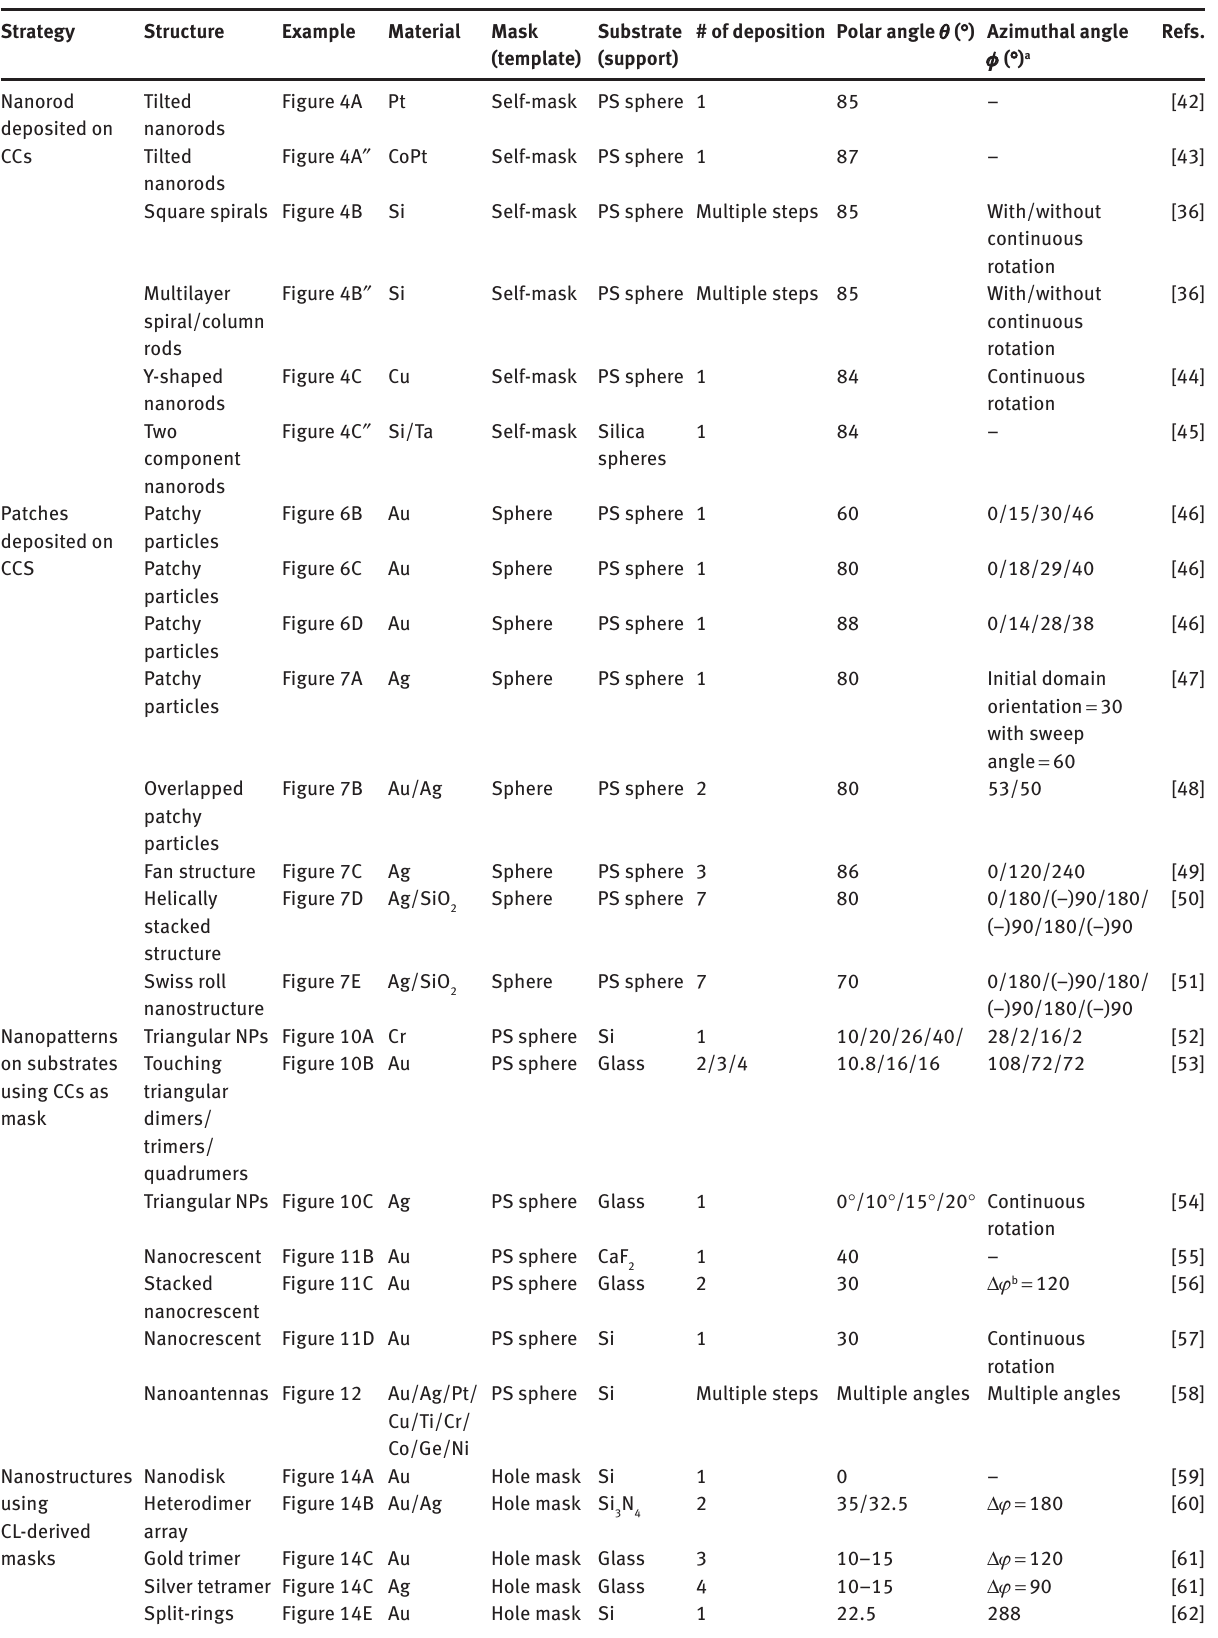
Table 1: Parameters of the typical nanostructures fabricated by SSL.